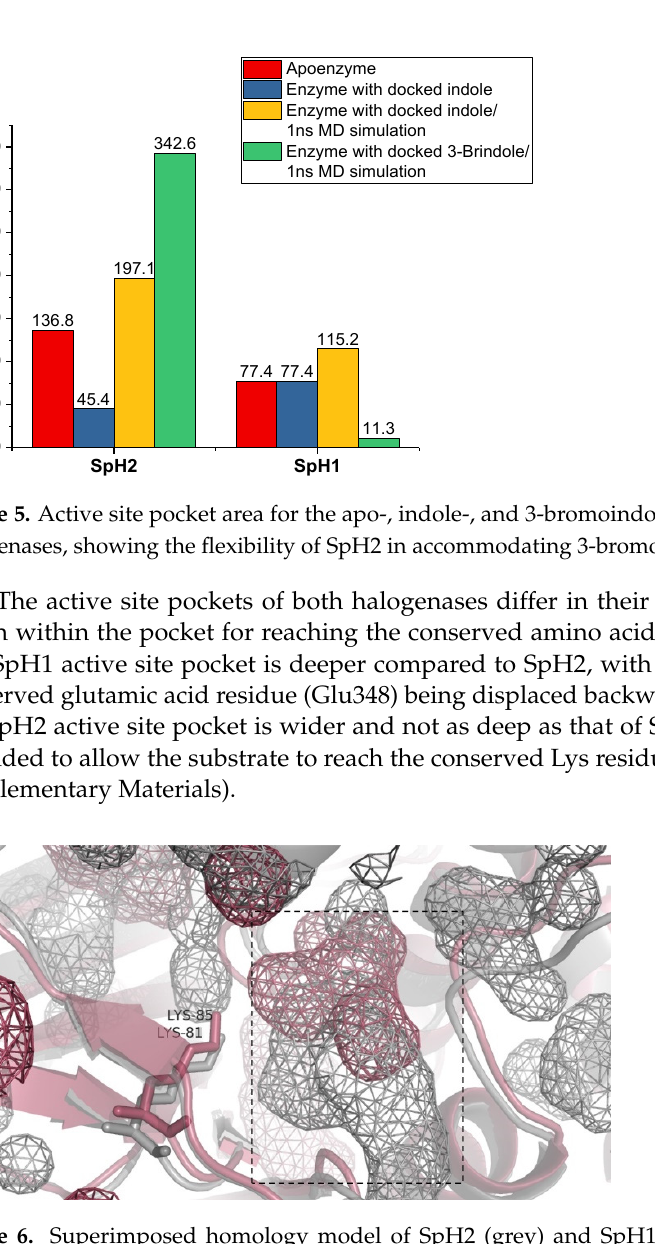
Figure 6. Superimposed homology model of SpH2 (grey) and SpH1 (red) after 1ns molecular dynamics (MD) simulation, showing the active site cavity in wireframe (in dashed-line box). The conserved active site lysine residues 81 and 85 in SpH2 and SpH1, respectively, are shown.